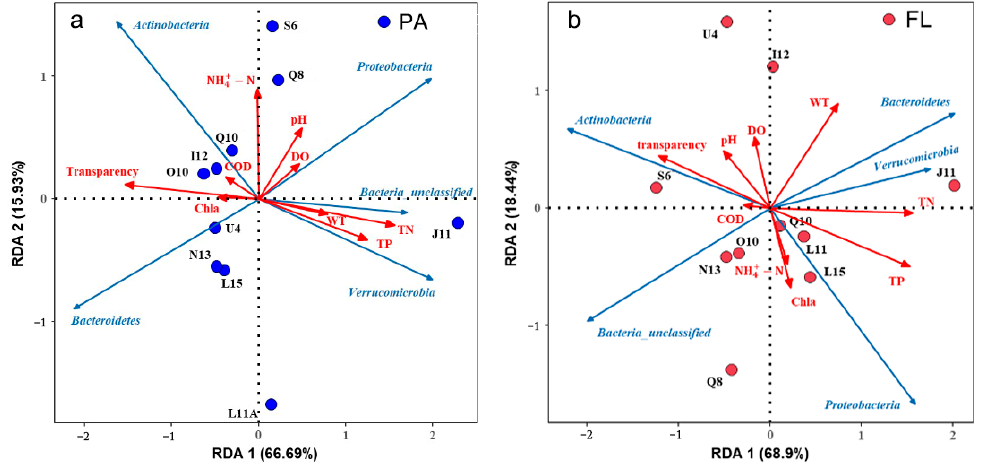
Figure 8. Redundancy analysis (RDA) of PA and physicochemical indicators in water ( a ); Redundancy analysis (RDA) of FL and physicochemical indicators in water ( b ).